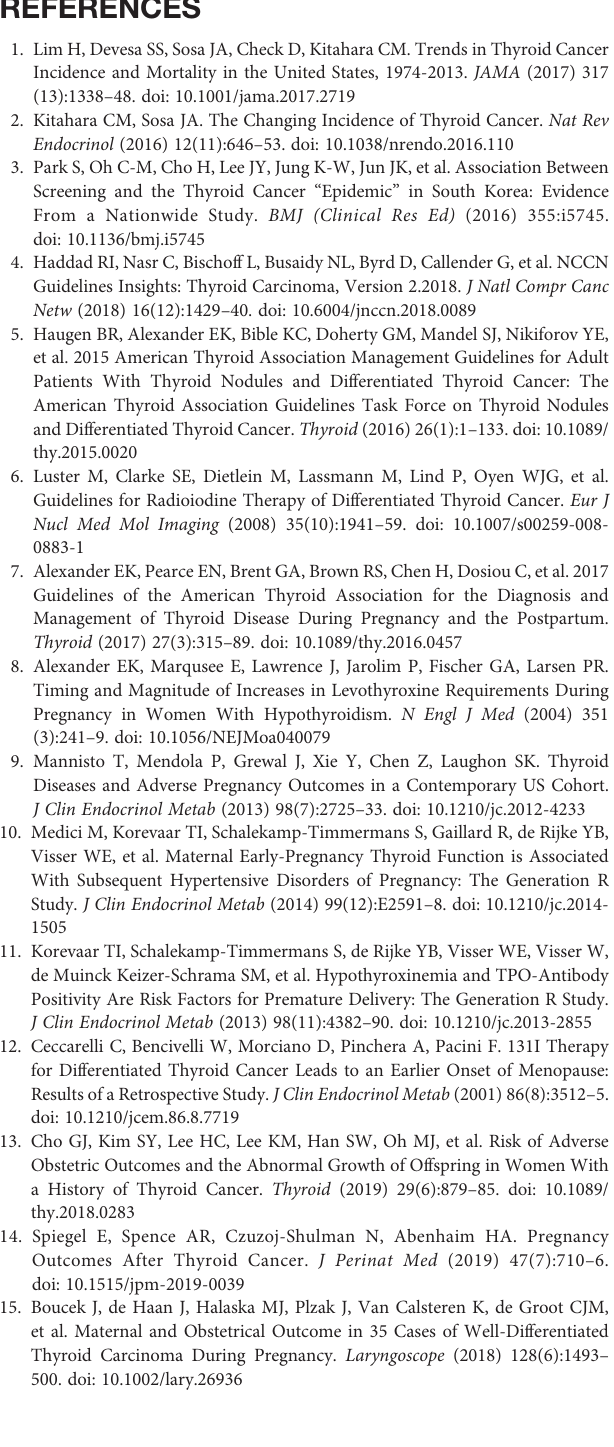
thyroid-stimulating hormone; TPO-Ab, thyroid peroxidase antibodies; GDM, gestational diabetes mellitus; PPH, postpartum